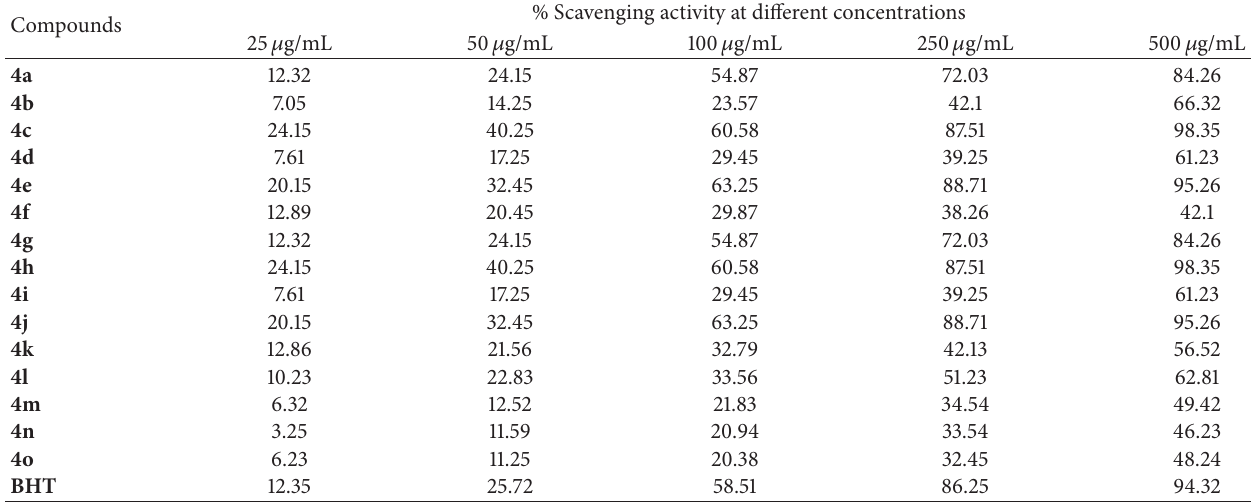
Table 4: Antioxidant activity.